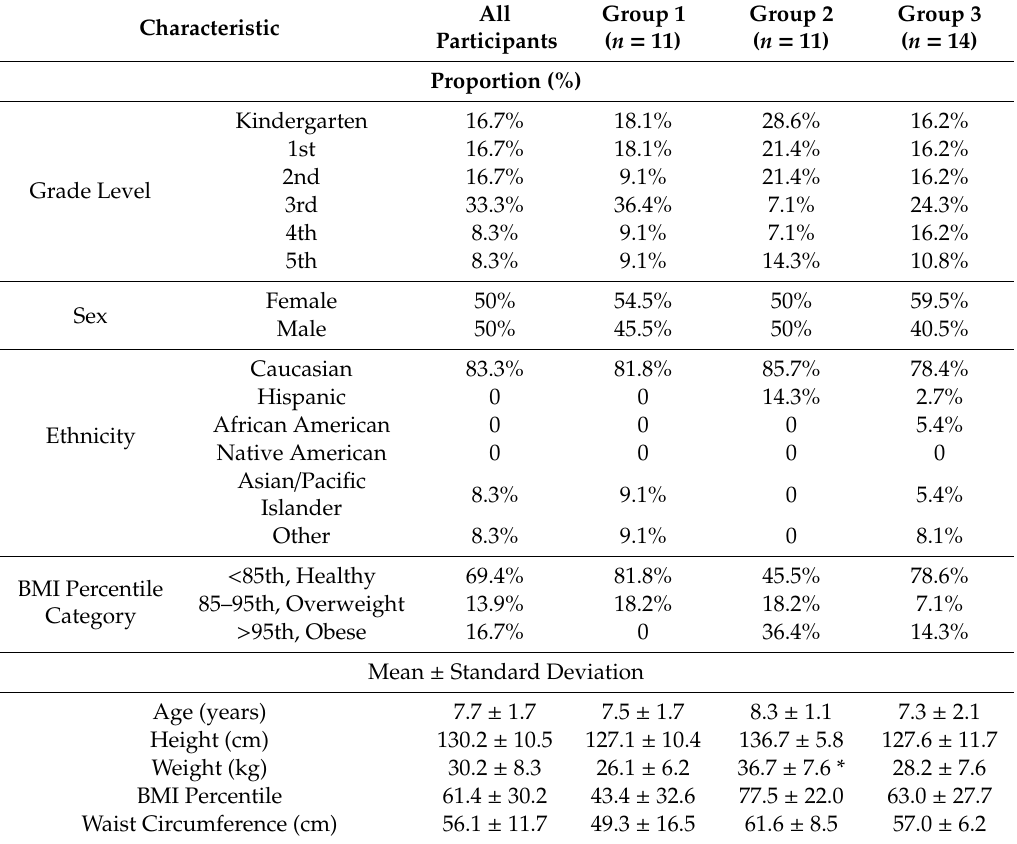
Table 2. Participant characteristics, all participants and by group.